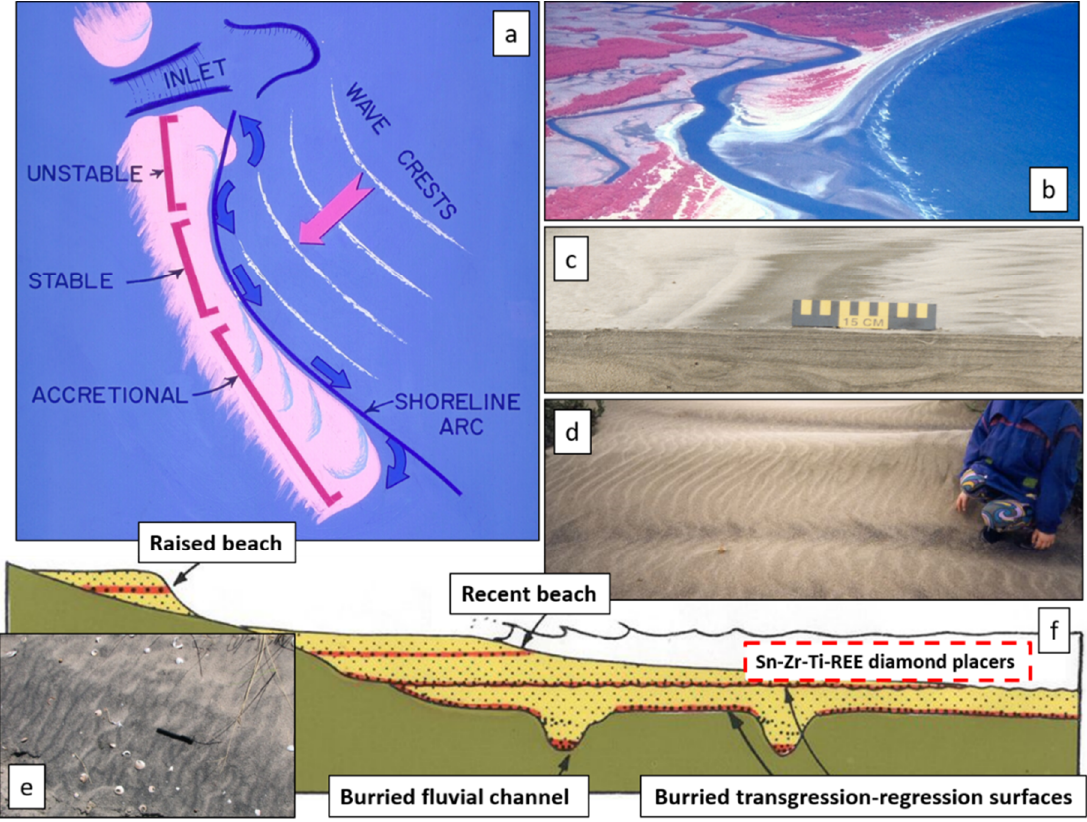
Figure 6. Nearshore marine and aeolian placers. ( a ) The linear barrier island shoreline configuration by M.O. Hayes illustrating the motion of waves and the sediment transport from the unstable zone to the zone of accretion. ( b ) Oblique aerial view of Capitain Sam’s inlet. The inlet migrates towards the S (bottom of photograph at a rate of 60 to 70 m per year) (photograph: courtesy of M.O. Hayes). ( c ) Ilmenite placers in coastal antidunes near the high-water line of the backshore environment at Kiawah Island, CA, USA. Arrowhead points towards the sea. ( d ) Sigmoidal-crested sand dunes with bifurcation at Lanzarote Island, Spain, with aeolian placers of magnetite and mafic minerals. ( e ) Two different types of heavy mineral accumulations. First generation heavy mineral accumulation produced during storms resulting in shoreline-parallel layers at the boundary between the dunes and the backshore (see for scale black biro—8 cm-parallel to the shoreline). Second generation heavy mineral redeposition in bifurcating asymmetrical ripples as a consequence of wind and water parallel to the shoreline in NE Patagonia, Argentina. ( f ) Cartoon to show the association of buried fluvial placers and beach placers of different generations [38].